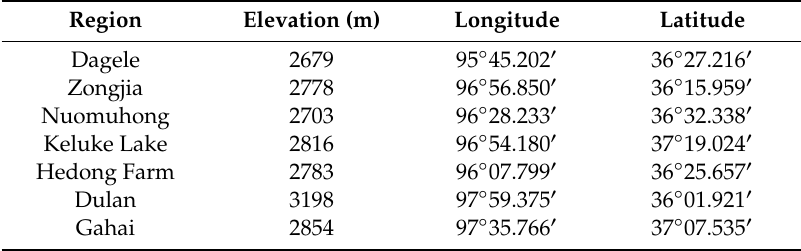
Table 5. Information of the collected Nitraria tangutorum Bobr. sample in Qinghai-Tibet Plateau. Region Elevation (m) Longitude Latitude Dagele 2679 95 ◦ 45.202